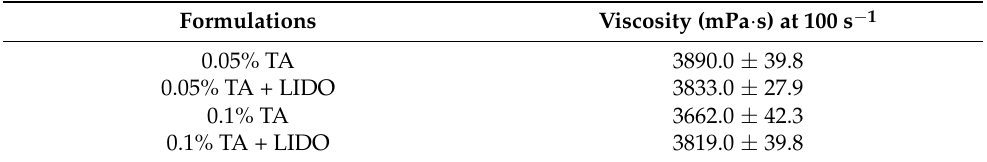
Table 2. Rheological evaluation of the different formulations at 100 s − 1 . Values represent Means ± SD ( n = 2).